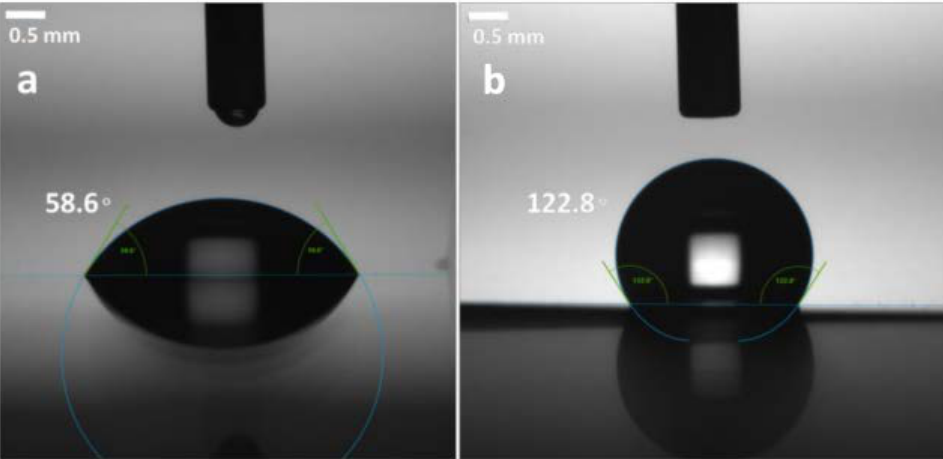
Figure 8. Water contact angle of PI membrane ( a ) before and ( b ) after coated with SiO 2 antireflective